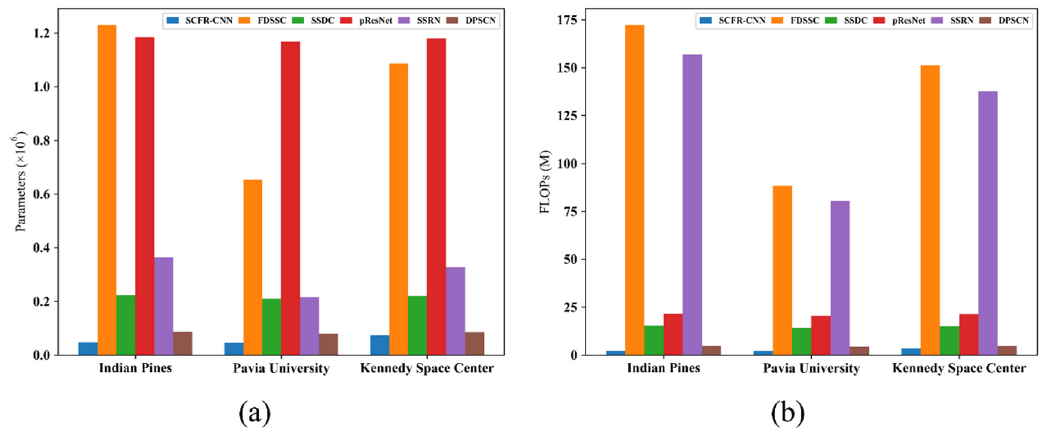
Figure 7. The number of trainable parameters and FLOPs of different CNN models: ( a ) training parameters; ( b ) Floating Point Operations (FLOPs).